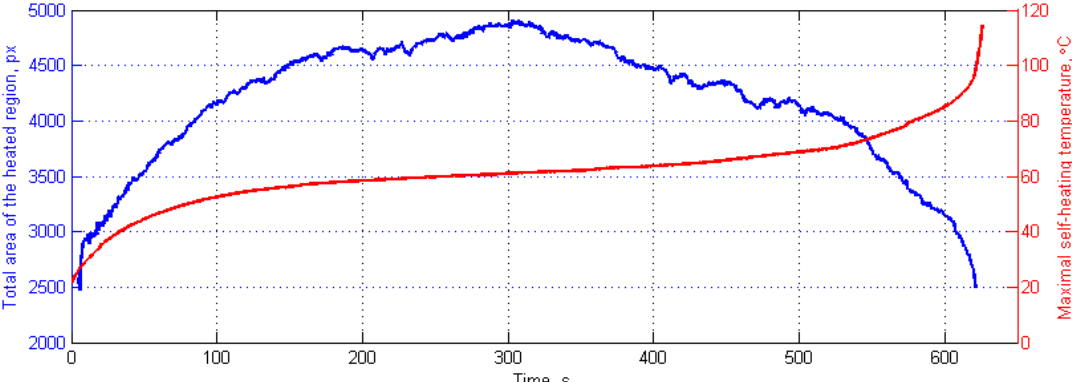
Figure 12. The evolution of a total area of a heated region with the corresponding maximal self-heating temperature history.